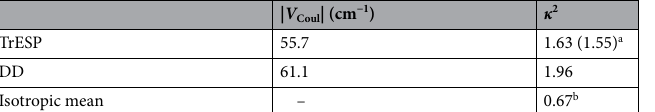
Table 1. Electronic coupling energies in absolute value (| V Coul |) and orientation factors ( κ the TrESP (Eq. (10)) and DD methods (Eq. (8)). Isotropic mean of κ parenthesis is the average of the orientation factors shown in Fig. 3. b Corresponding to